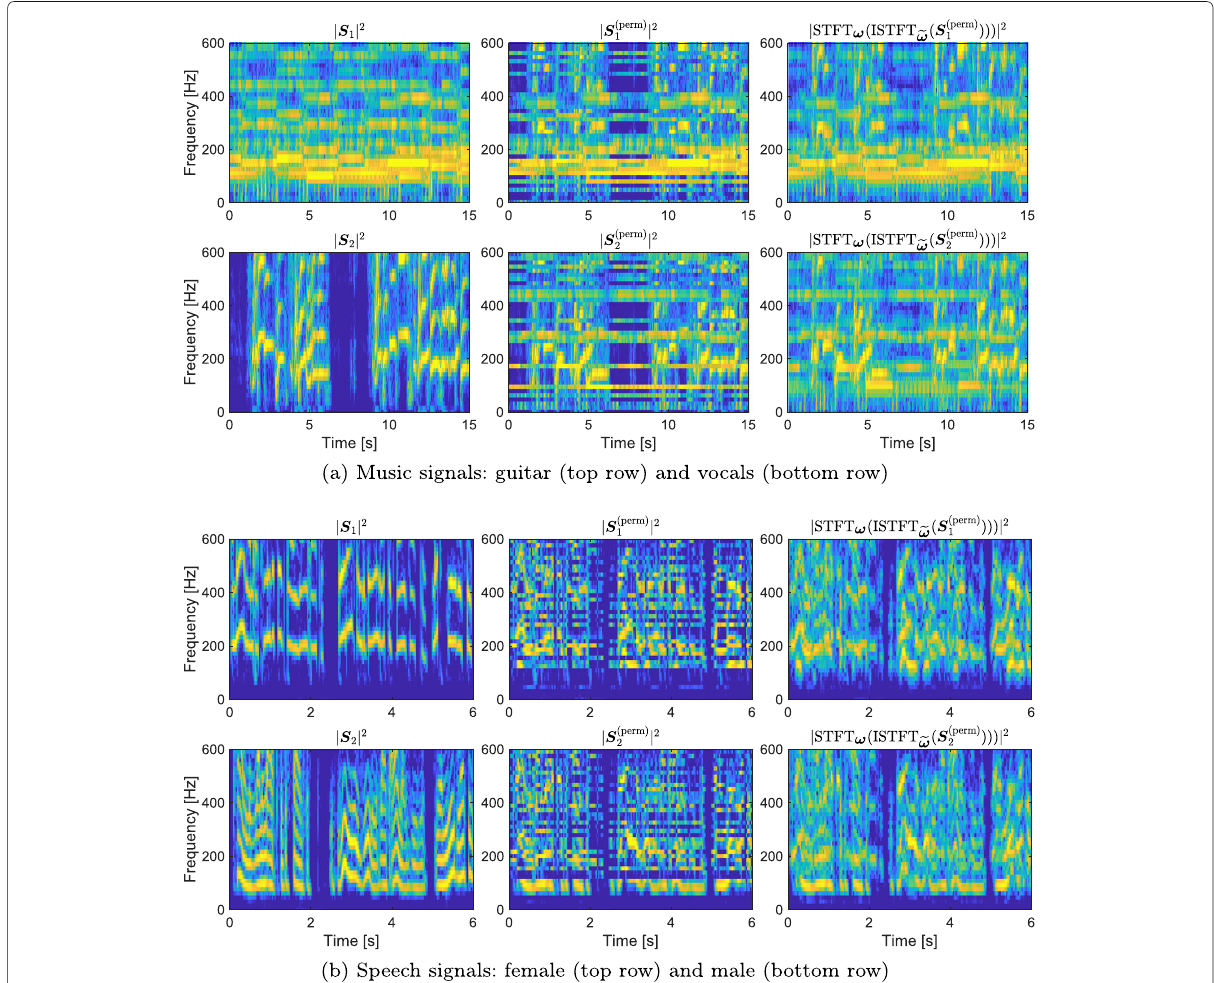
Fig. 2 Smoothing effect of spectrogram consistency applied to permutation misaligned signals: a music and b speech. The left column shows the original source signals | S n | 2 , and the center column shows their randomly permuted versions, which simulates the permutation problem and is denoted as S ( perm ) n . The right column shows the consistent versions of S ( perm )